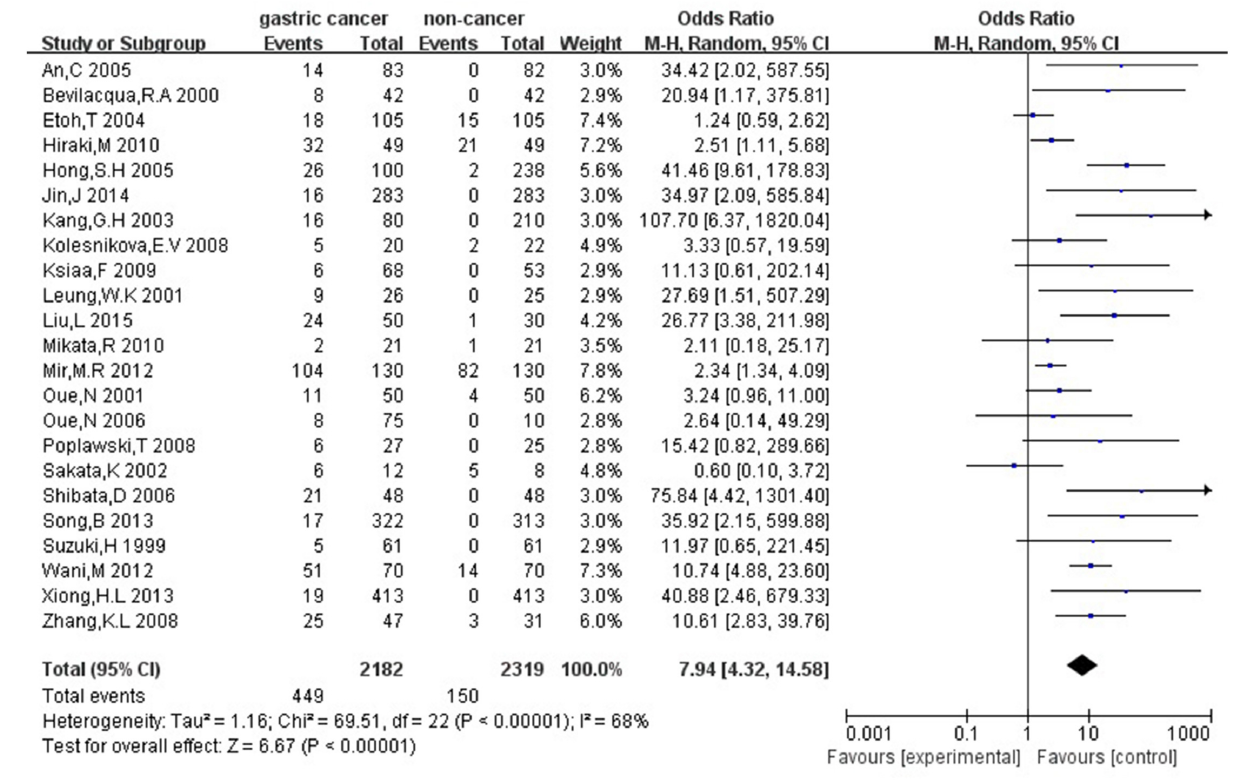
Frontiers in Physiology |